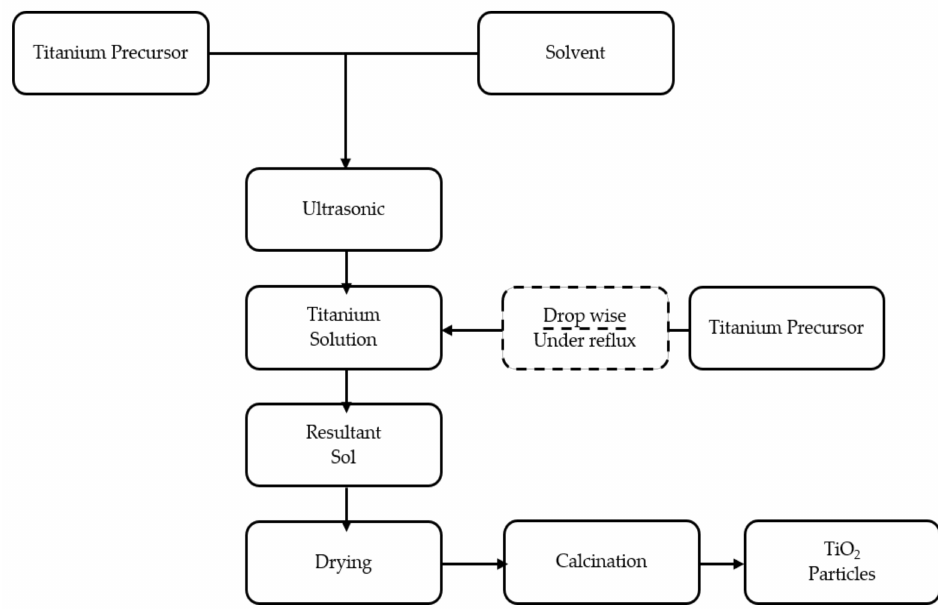
Figure 8. Steps involved in the preparation of TiO 2 nanoparticles via sol-gel